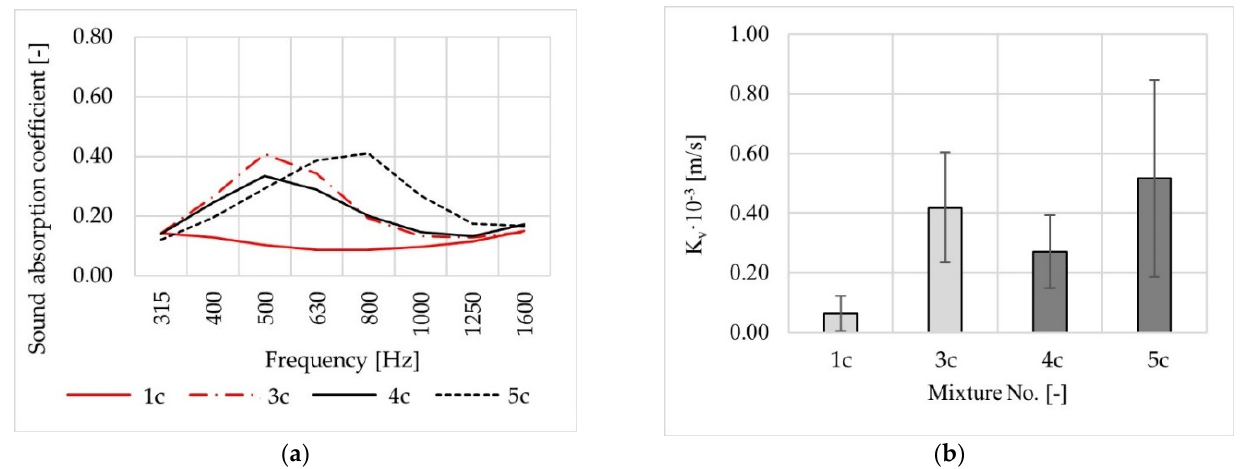
Figure 15. Test results for cylindrical specimens of mixtures chosen for placement on test sections: sound absorption coef- ficient ( a ), vertical water permeability ( b ).